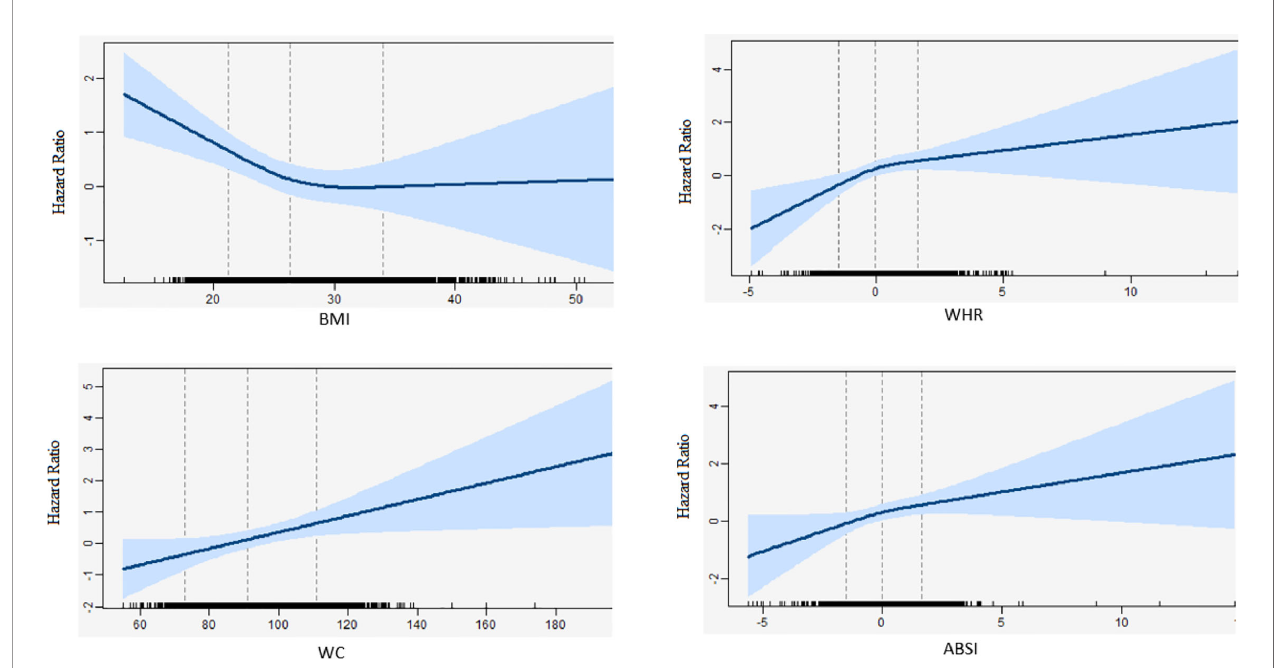
FIGURE 1 | Natural cubic splines in a standard cox-regression model with knots at 22, 27, 34 and 72, 92, 112, and -1.5, 0, 1.5 and -1.5, 0, 1.5 for BMI, WC, WHR, and, ABSI respectively. The blue line represents the hazard ratios for the risk of lung cancer with the corresponding 95% con fi dence interval. Hazard ratios were adjusted for sex, age, cohort (RS-I/RS-II/RS-III), physical activity (continuous), alcohol intake (continuous), pack-years (continuous), education (high/low), WCRF adherence score (continuous), and diabetes mellitus (yes/no). WC and WHR were additionally adjusted for